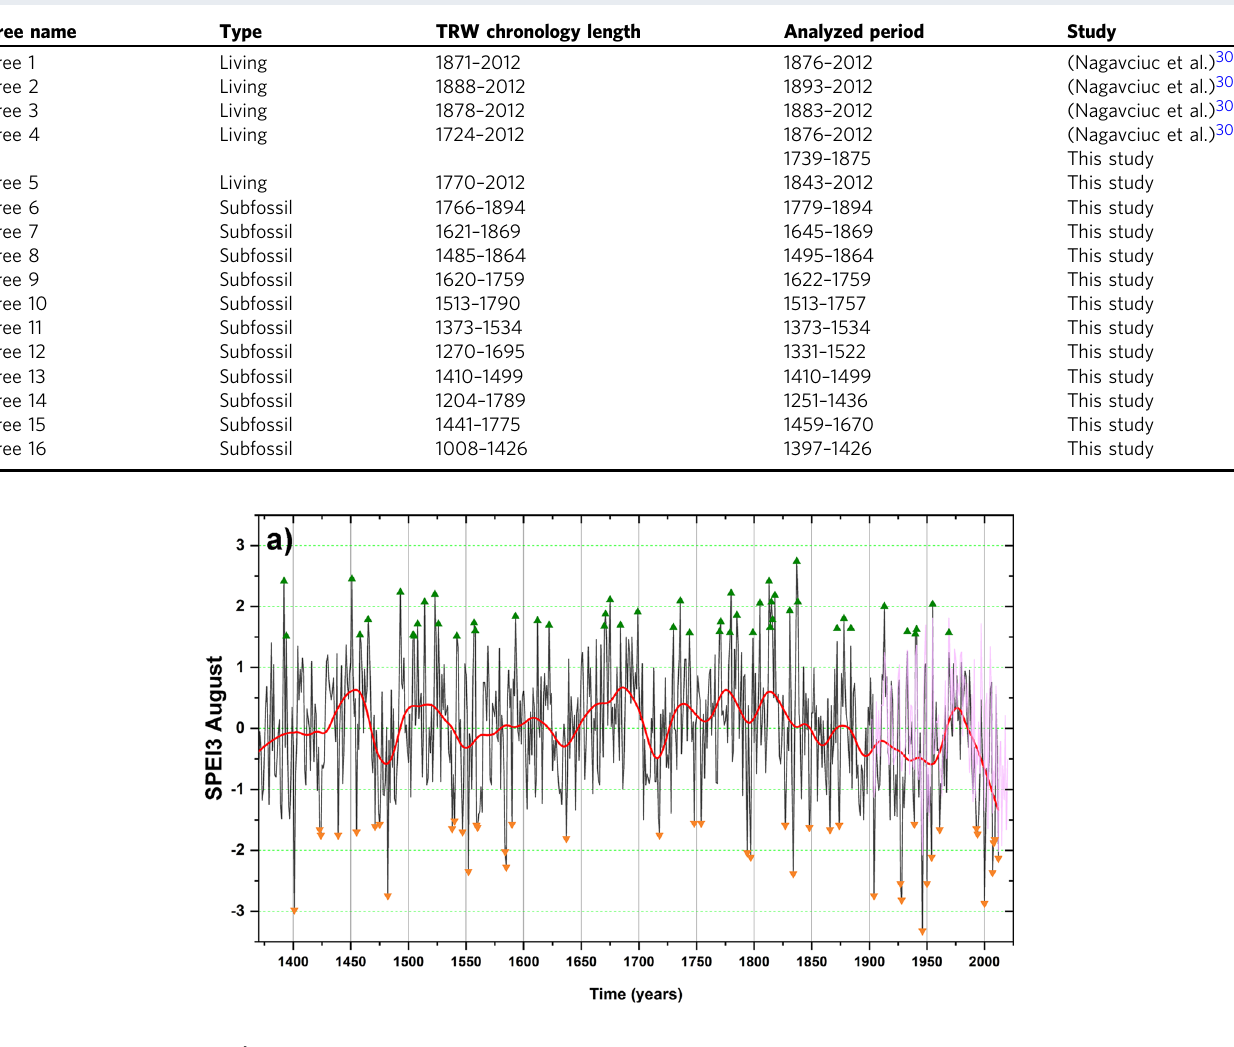
Table 1 The analyzed trees and tree ring chronology length.